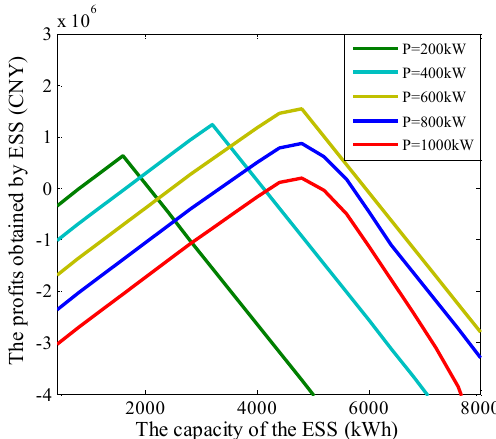
Figure 5. The profit curves of different rate powers of ESS.